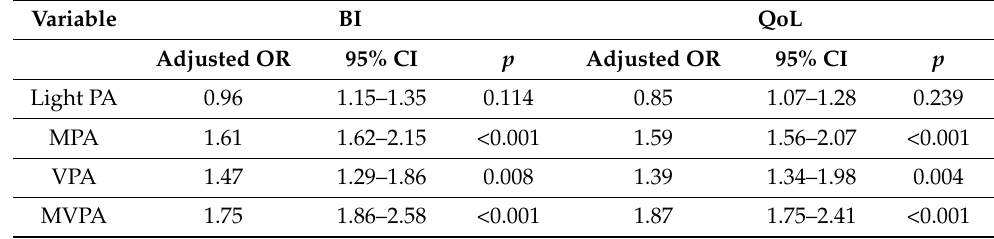
Table 3. Results of correlations between variables for young adults with financial status and education as